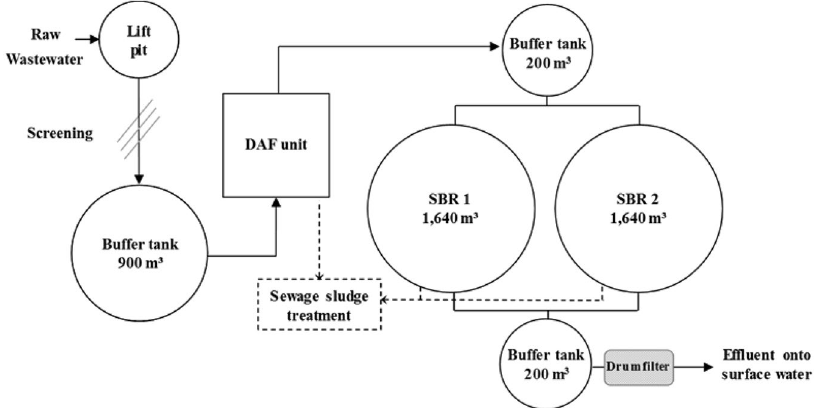
Figure 1. Flow diagram of the dairy wastewater treatment plant. The raw wastewater was screened then collected in an equalization buffer tank. During production, a second buffer tank received a continuous flow from the dissolved air flotation (DAF) unit. The wastewater was then treated with two conventional sequential batch reactors (SBR1 and SBR2) operated in parallel. The effluent was collected in a buffer tank, screened through a drum filter and released in the receiving